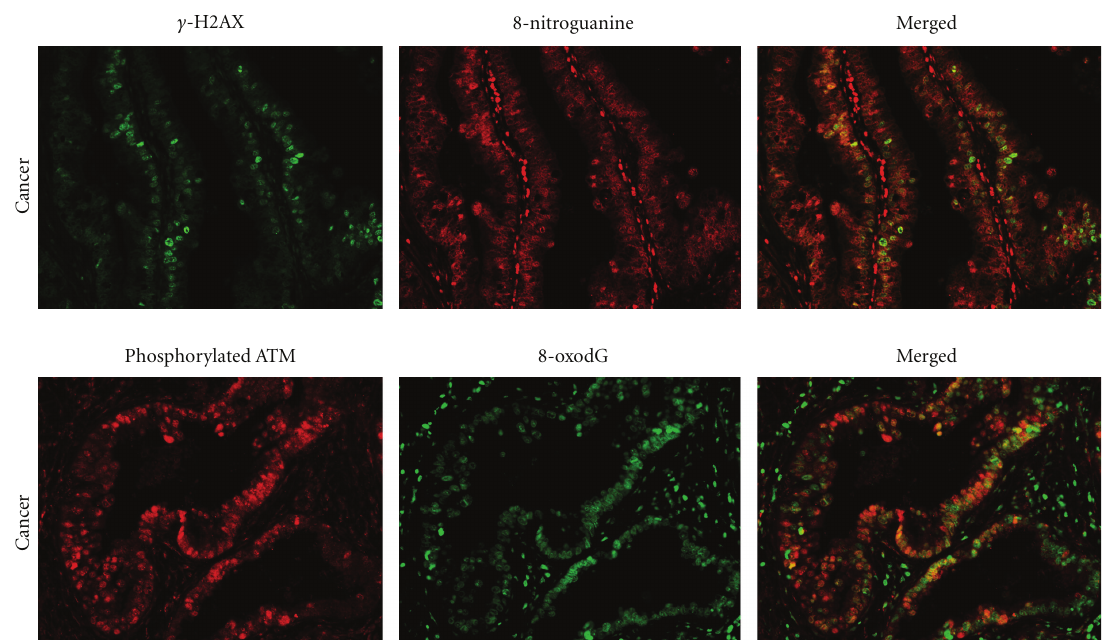
Figure 3: Colocalization of DDR proteins and DNA lesions. (a) Colocalization of γ -H2AX (green) and 8-nitroguanine (red). (b) Colocal- ization of phosphorylated ATM (green) and 8-oxodG